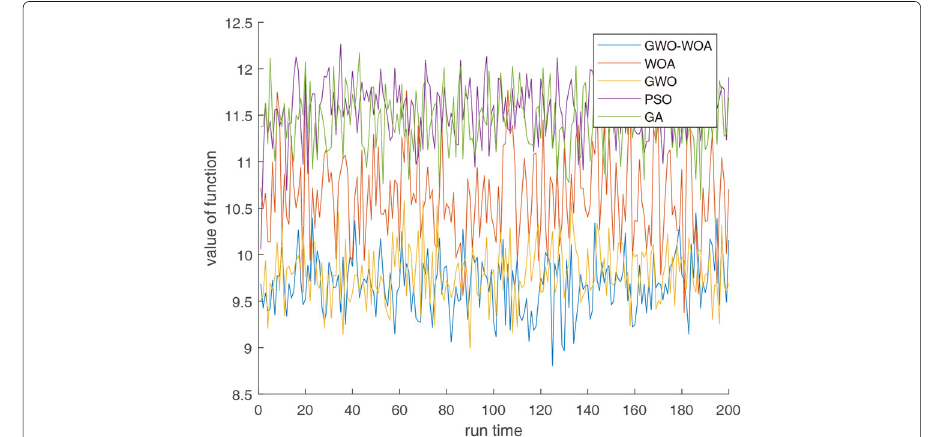
Fig. 6 The results of each run time of algorithms when device number is